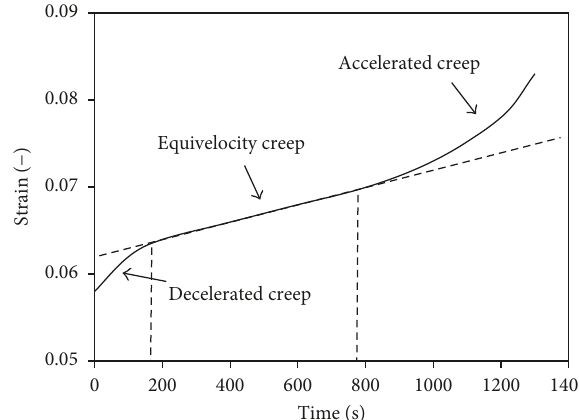
Figure 2: A typical creep curve of asphaltic mixture at a temper- ature of 50 ° C and stress of 0.25MPa.